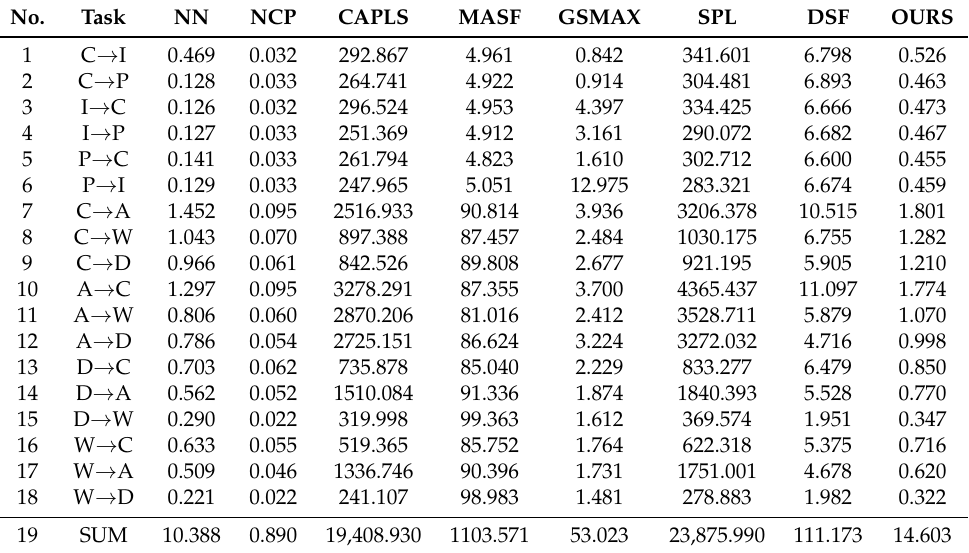
Table 4. Running time (seconds) on ImageCLEF (Nos. 1–6) and Office-Caltech10 (Nos.